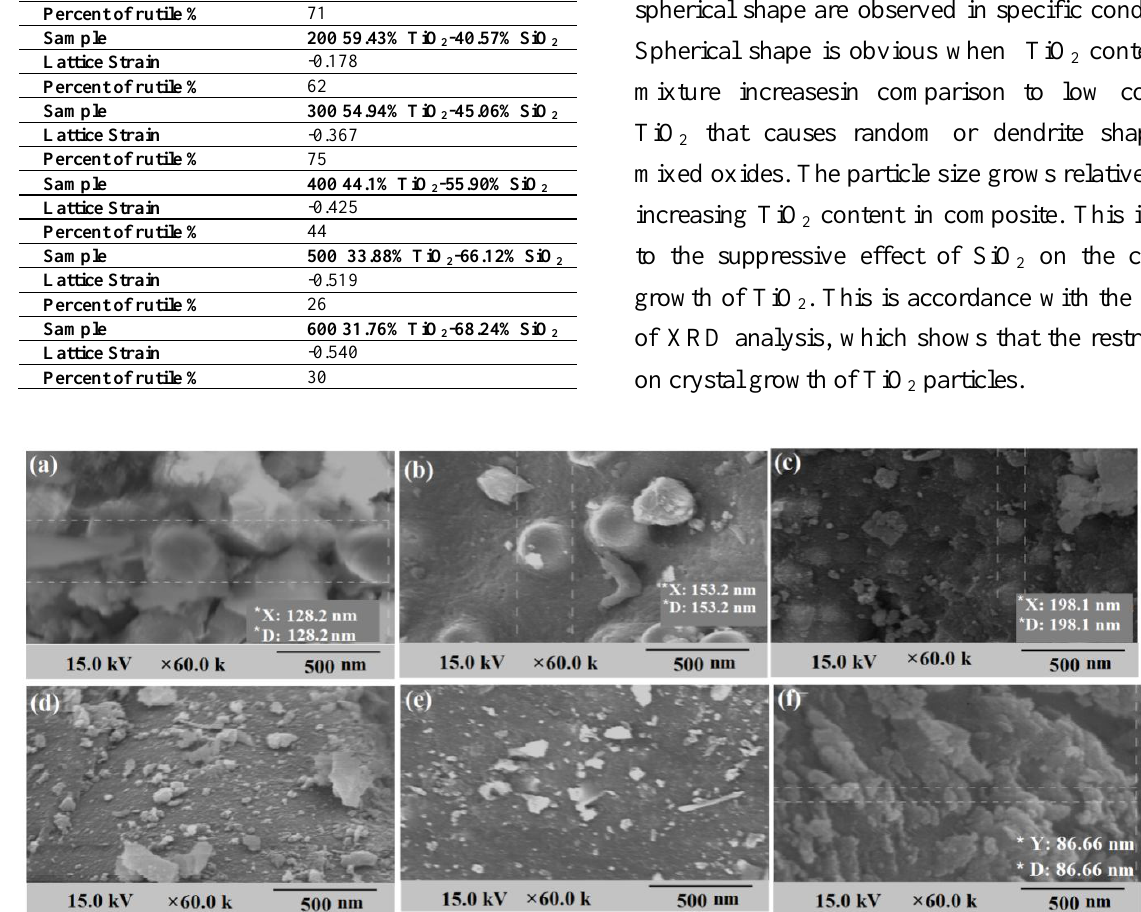
content in composite, (a) sample 100, (b) sample 2